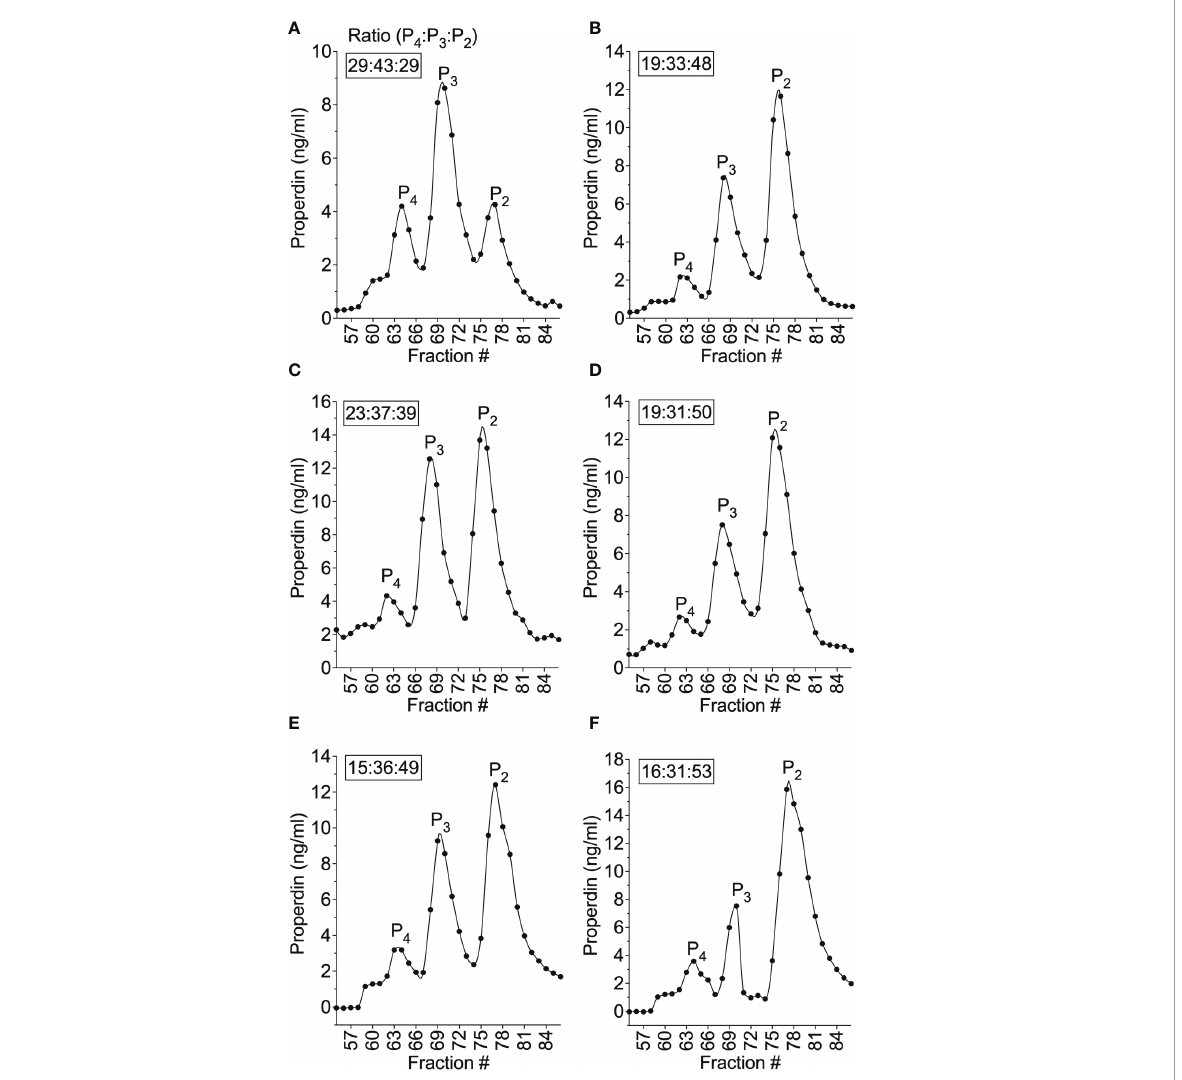
FIGURE 9 Properdin oligomeric distribution differed between neutrophil-derived and serum-derived properdin and was skewed towards dimers. The ratios of properdin oligomers in serum from donor #4 (A) and PMA-activated neutrophil supernatant from donor #4 (B) , and PMA-activated neutrophil supernatant from donor #6 (C) , #7 (D) , #8 (E) , #9 (F) were determined by size exclusion chromatography and properdin concentration by sandwich ELISA as described in “ Materials and Methods ” (section 2.5 and 2.6) and the data was graphed by properdin concentration. The ratios of properdin oligomers were calculated as described in “ Materials and Methods ” (section 2.7). and indicated as an inset to each